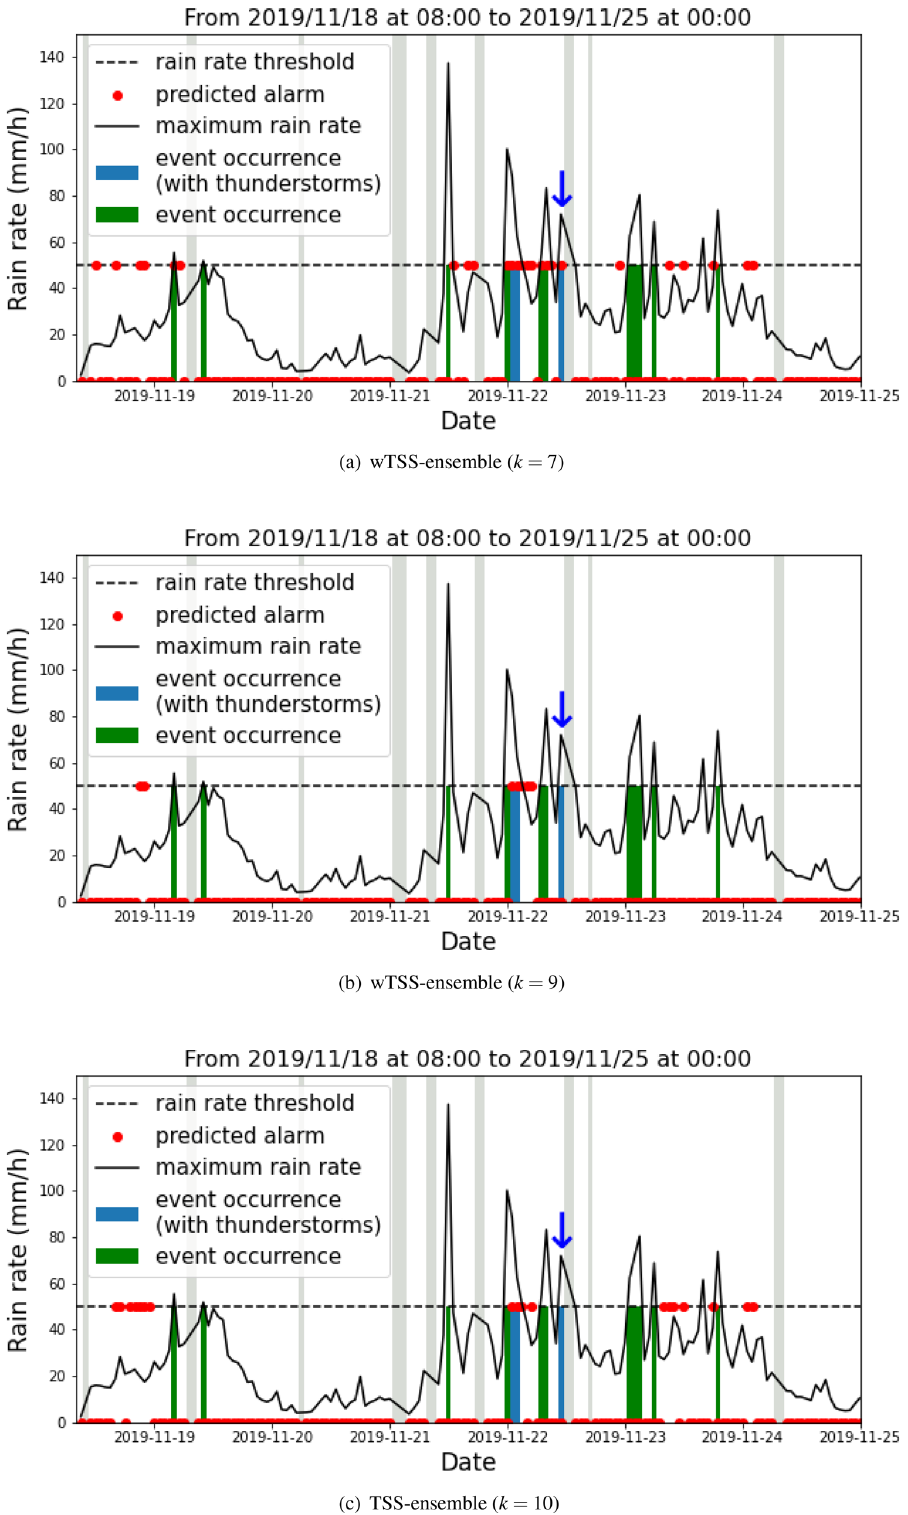
Figure 9. Predictions valid from 2019/11/18 at 08:00 UTC to 2019/11/25 at 00:00 UTC obtained by applying the wTSS-ensemble strategy at k = 7 run (top panel), the wTSS-ensemble strategy at k = 9 run (central panel) and the TSS-ensemble strategy at k = 10 run (bottom panel). The grey boxes correspond to times when the input data are